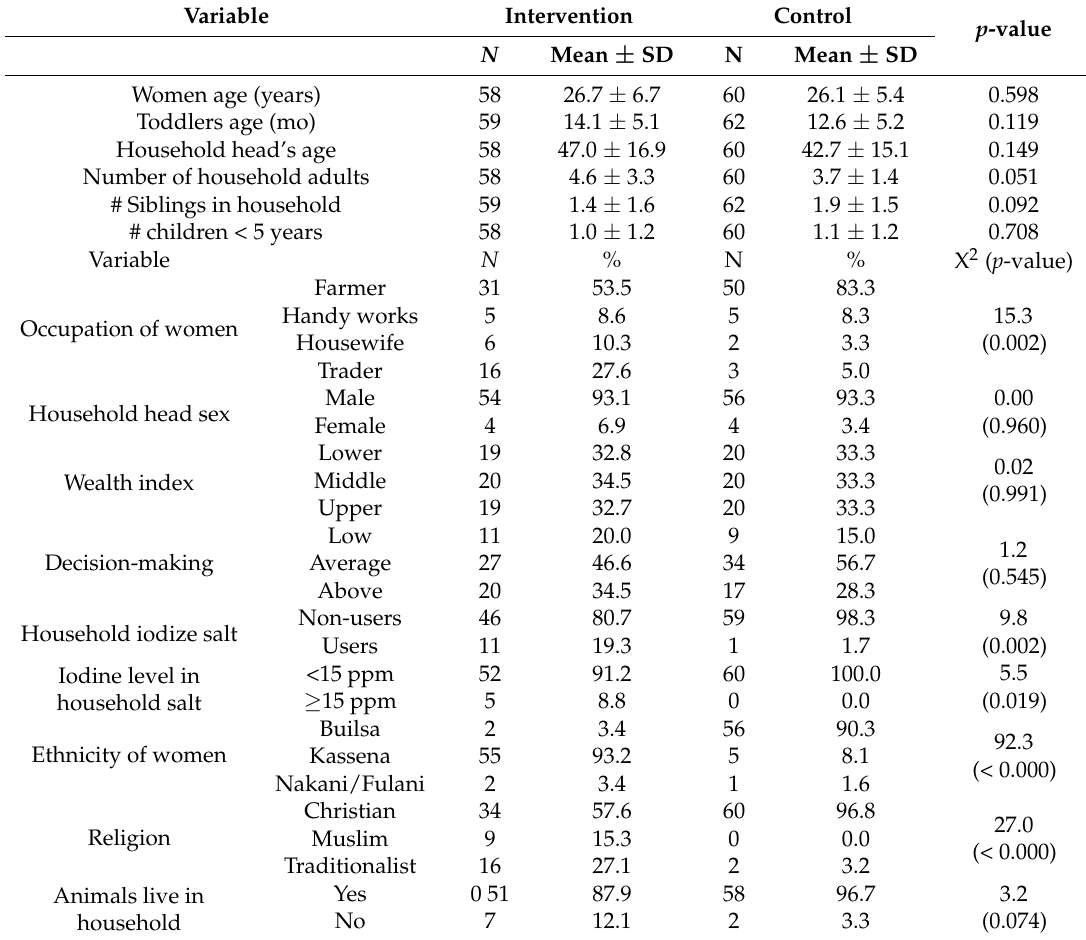
Table 3. Demographic characteristics of childbearing age women (15–49 years) and their toddlers (6–23 months) in intervention and control groups at baseline.